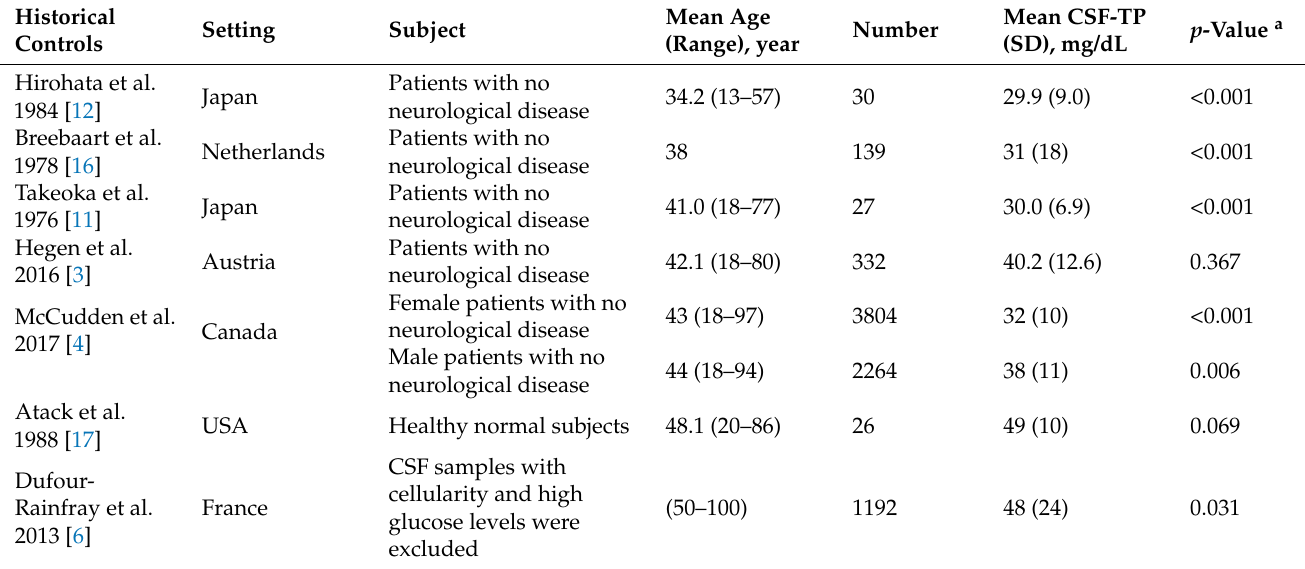
Table 3. Comparison of CSF-TP concentration with previous